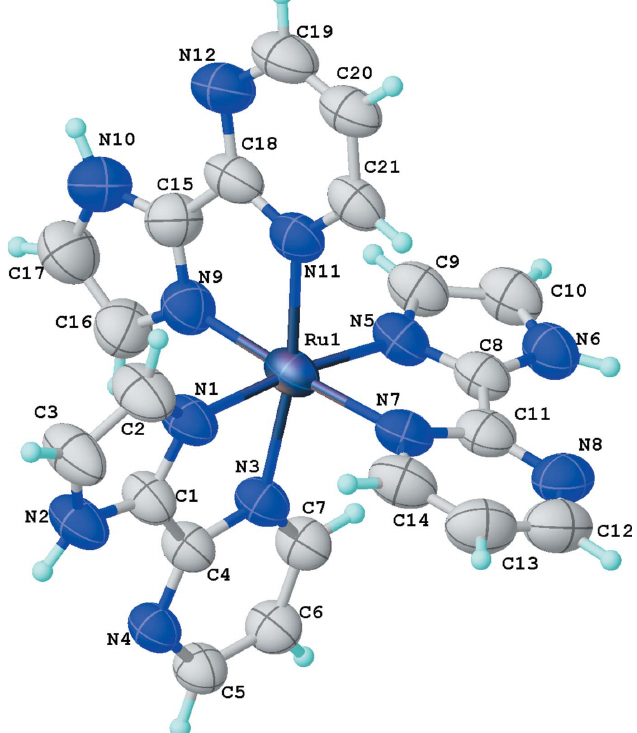
Figure 1 The molecular structure of the homoleptic cationic complex [Ru( L ) 3 ] 2+ ( L = C 7 H 6 N 4 ) with the atom-numbering scheme. Displacement ellipsoids are plotted at the 50% probability level.